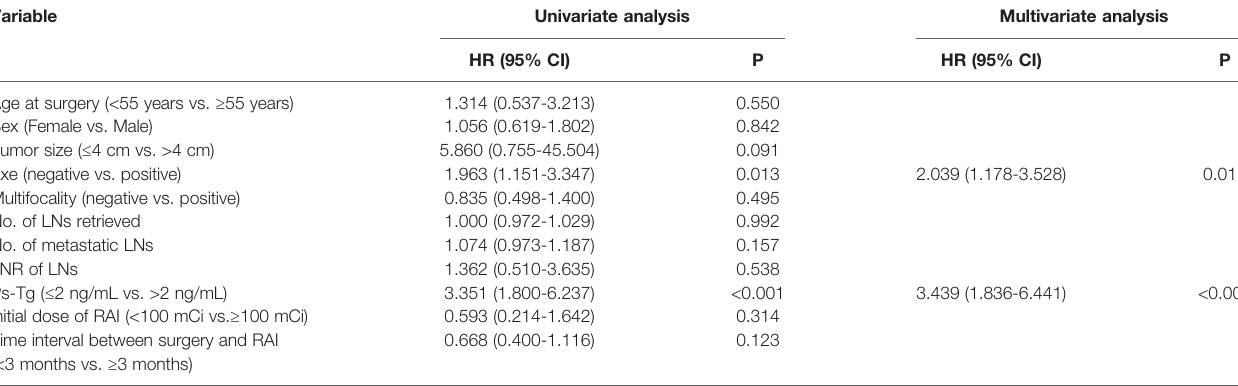
TABLE 3 | Univariate and multivariable analyses of prognostic factors for excellent response for pN1a PTC patients. Variable